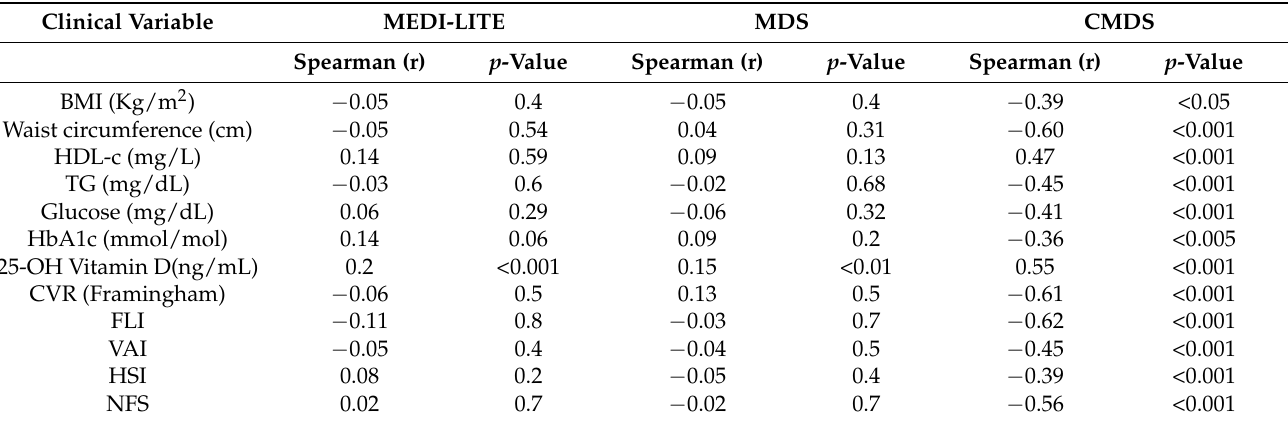
Table 5. Analysis of correlations between Mediterranean diet scores, clinical and biochemical